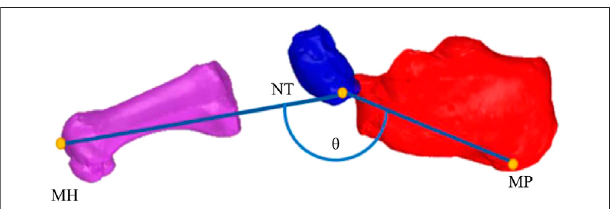
FIGURE 5 | Bones and landmarks de fi ning the MLA angle ( θ